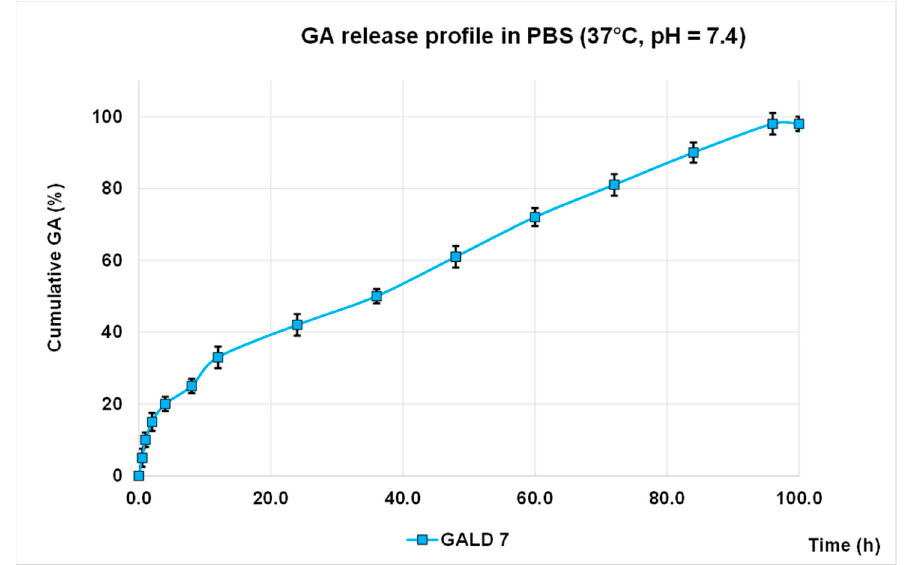
Figure 8. GA release profile in PBS, at 37 °C and pH = 7.4 expressed as cumulative percentage of